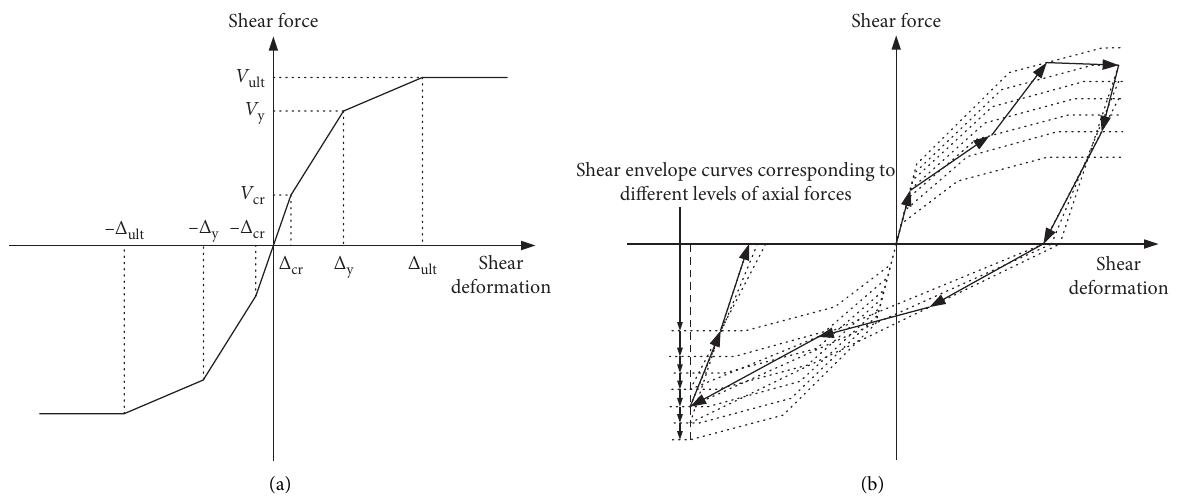
Figure 1: Hysteretic shear-axial interaction representation. (a) Quatrilinear symmetric envelope curve. (b) Shear stiffness transitions due to axial force